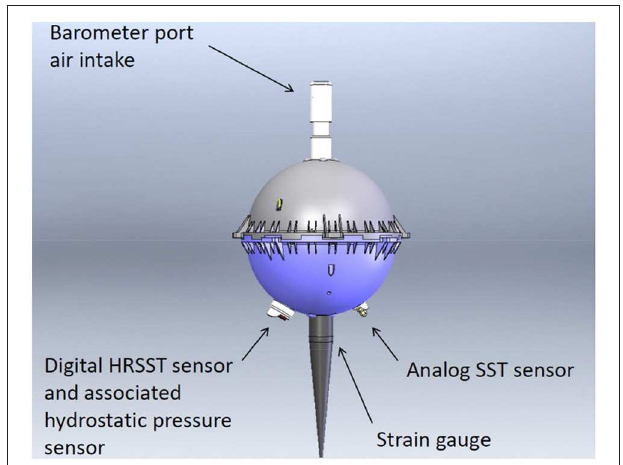
FIGURE 2 | Schema of the buoy with its sensors (the line, the stainless bracket and the holey sock drogue are not represented). Doc. ® nke Instrumentation.